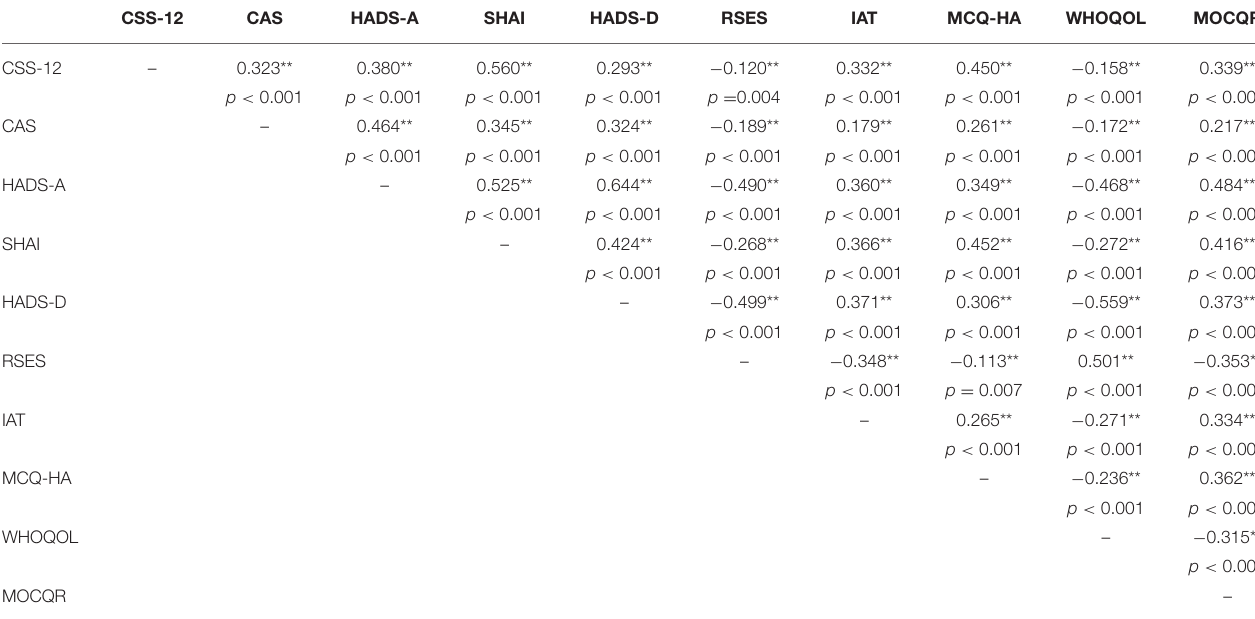
TABLE 4 | Correlations between the Cyberchondria Severity Scale (CSS-12) and psychometric questionnaires.